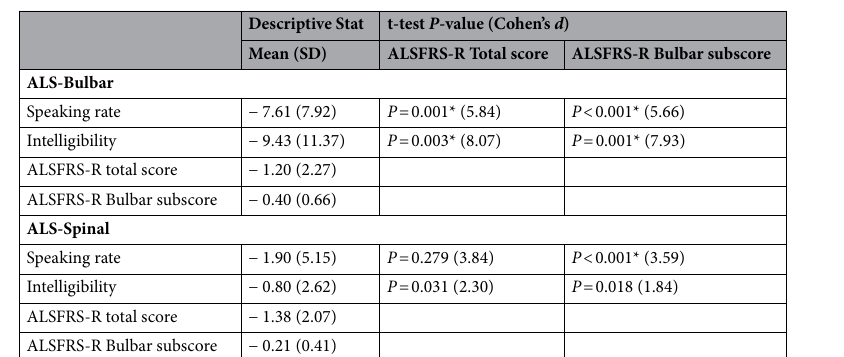
Table 5. Mean (SD) of slope of change in speech measures and ALSFRS-R total score and ALSFRS-bulbar subscore in ALS bulbar and spinal groups. T-test results for the comparison between longitudinal changes in speech measures and ALSFRS scores are also provided. Asterisks represent comparisons that remained statistically significant after adjusting p-values for multiple comparisons (adjusted p-value = 0.0125).